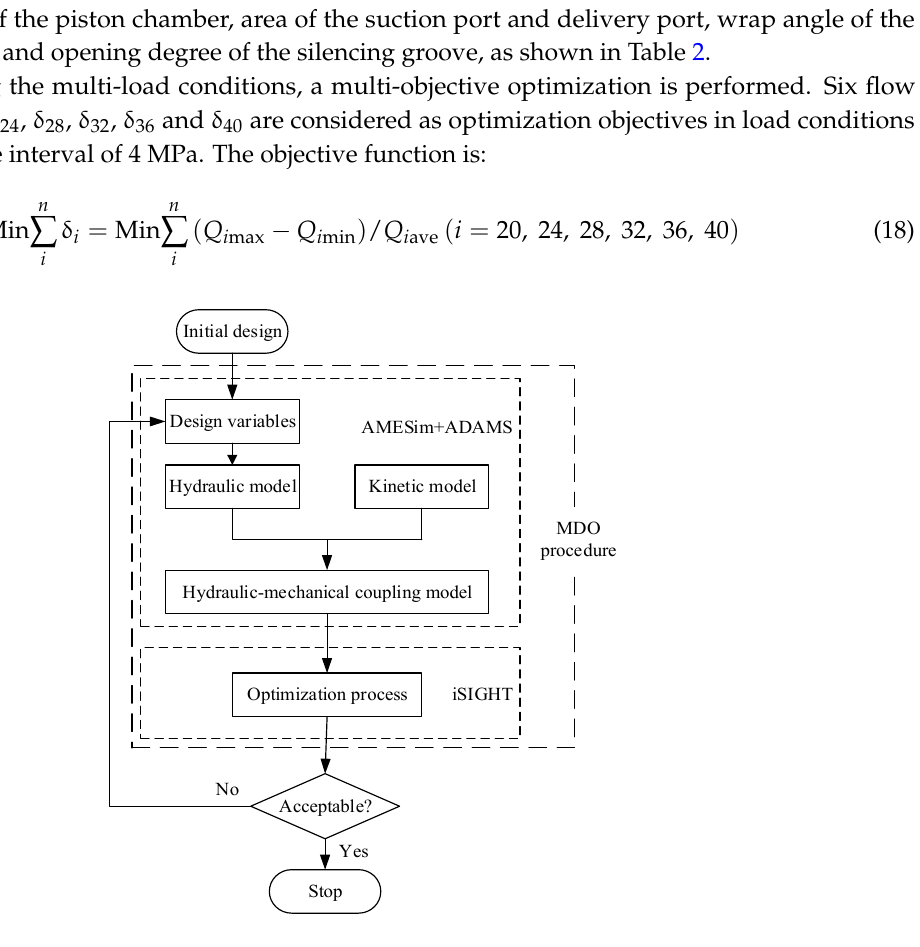
Figure 6. MDO procedure for the pump. Table 2. Design variables.